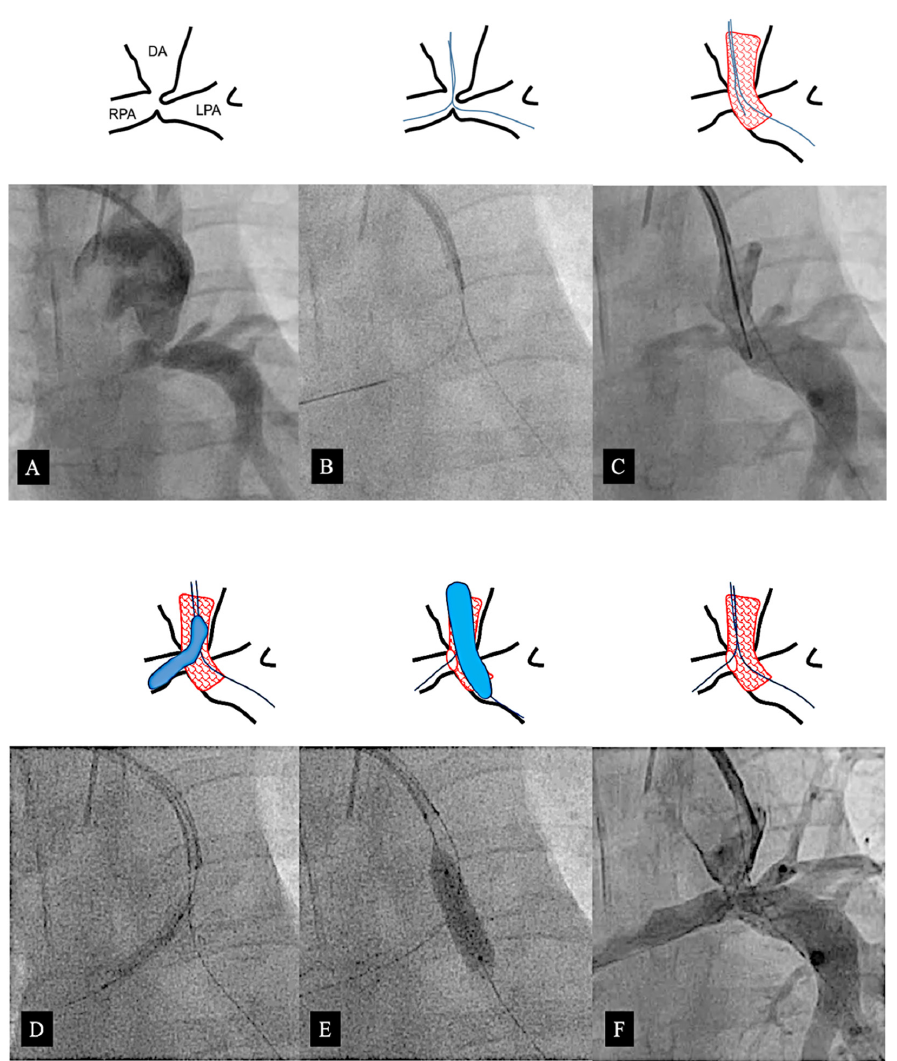
Figure 5. Stenting of vertical ductus arteriosus (DA) associated with bilateral proximal pulmonary artery branch stenosis, small right PA, and large ductal ampulla. ( A ) Selective hand injection of the DA in frontal projection. ( B ) Two buddy wires were placed in the left and right PA for planning of the ductal stenting. ( C ) In this case, due to straighter course of the left guidewire with more stenosis of the left PA origin, the stent was placed from the DA to cover proximal part of the left PA with intention to jail the right PA ostium. Thereafter, the right PA was re-crossed with the microcatheter system. ( D ) The stent strut and the proximal right PA was then dilated to improve flow to the right lung. ( E ) Subsequently, the whole stent was re-dilated for proper apposition to the vessel wall. ( F ) Selective angiogram after stenting demonstrated adequate flow through both pulmonary arteries. RPA: Right pulmonary artery, LPA: Left pulmonary artery.